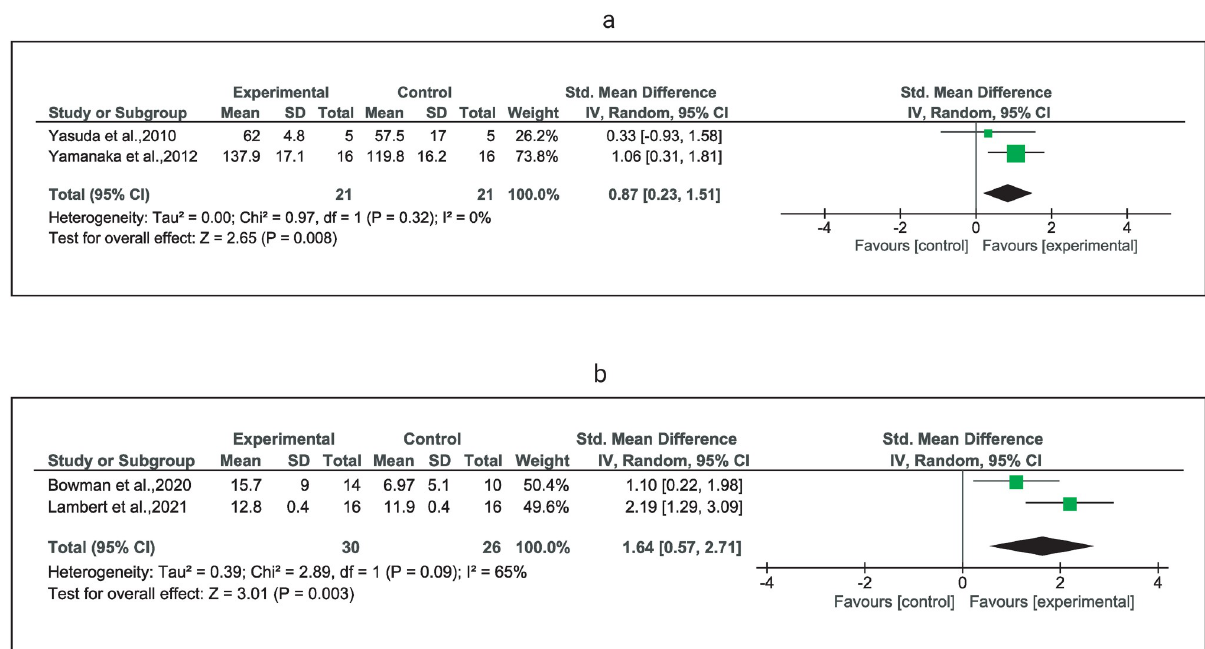
Fig 2. Forest plots depicting studies using LL-BFRT compared to studies using LL-RT in muscle strength. Forest plot comparing low-load resistance training with blood flow restriction (LL-BFR) and low-load resistance training alone (LL-RT) on muscle strength of a) chest press (1RM) b) shoulder flexion (dynamometry in kgs). Abbreviations: CI, confidence interval; IV, inverse variance; Random, random effects model; SE, standard error.